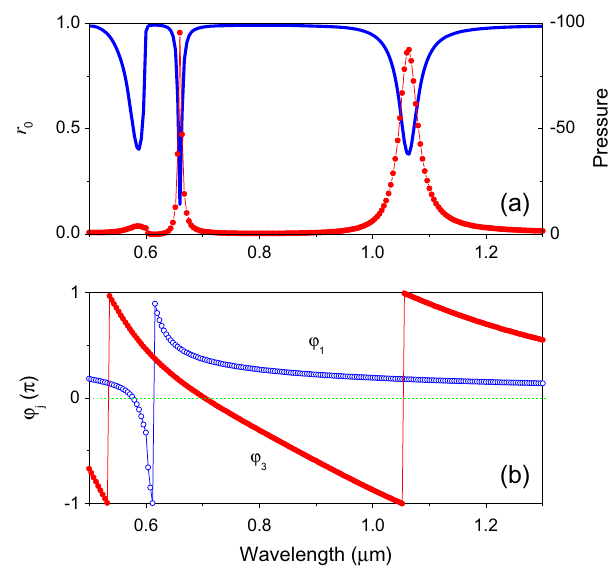
Figure 13. (a) Reflection spectrum (the line) and enhanced pressure (the circles) in the visible and near-infrared region; (b) Phase shift as a function of wavelength. Here d = 600 nm, a = 40 nm, h = 155 nm, and t = 20 nm. The resonance is mainly due to the grating surface mode rather than the SFP